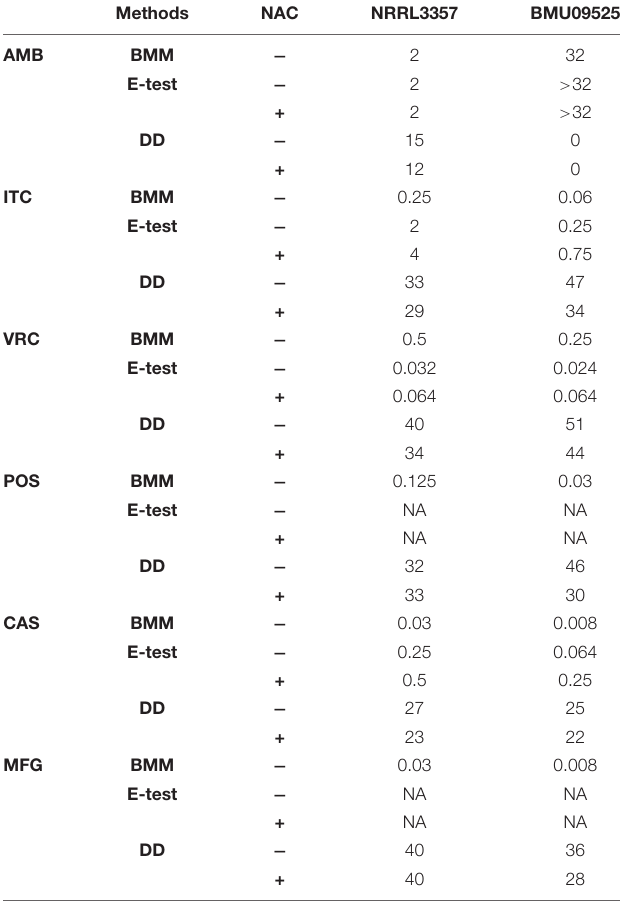
TABLE 2 | Antifungal susceptibility testing by the broth microdilution method ( µ g/mL), E-test ( µ g/mL), and disk diffusion (mm).